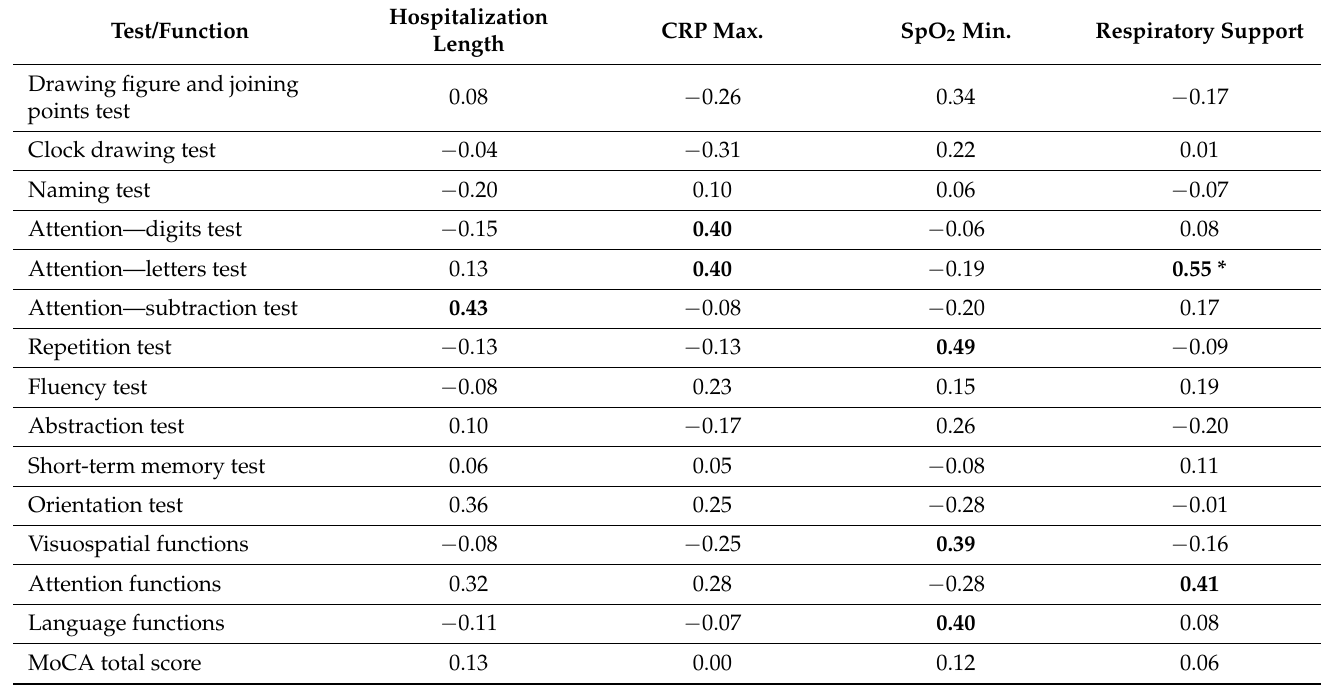
Table 2. Partial Pearson’s correlations among MoCA tests, functions and the clinical parameters with age and the education level